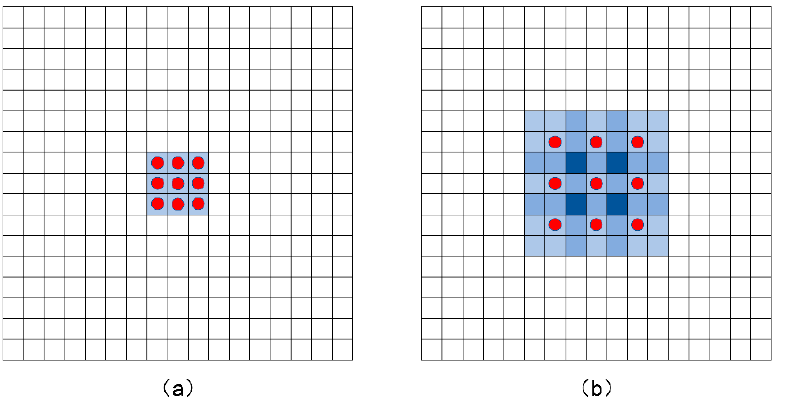
Figure 4. Dual multi-scale attention network.